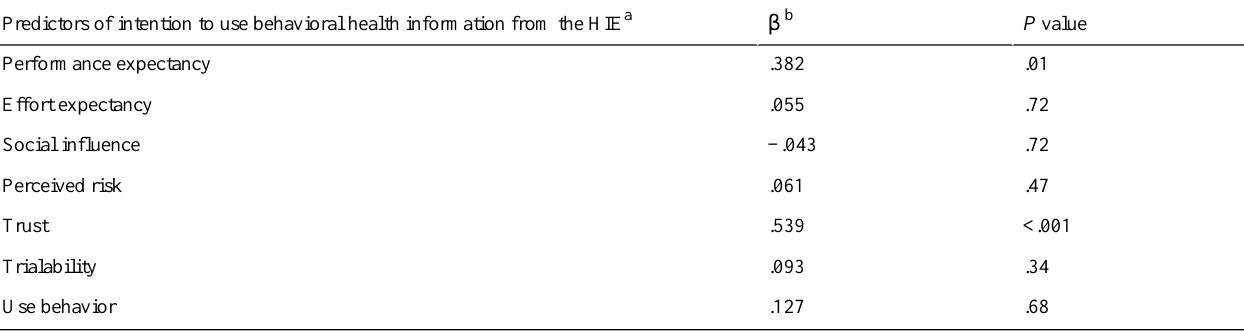
Table 2. Path analysis of the constructs within the conceptual